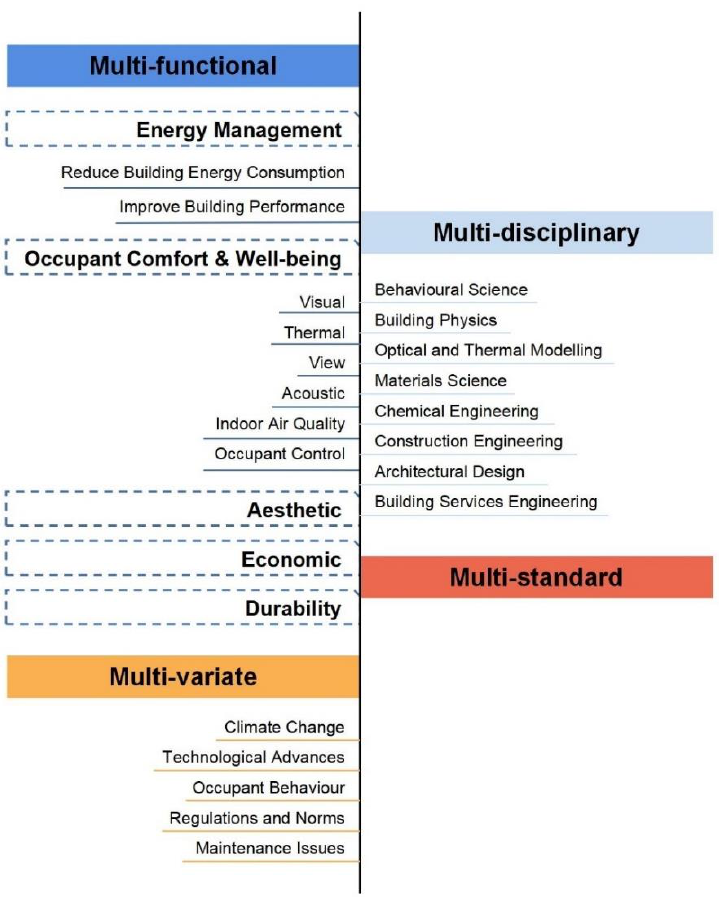
Figure 4. Distinctive features of AFs.